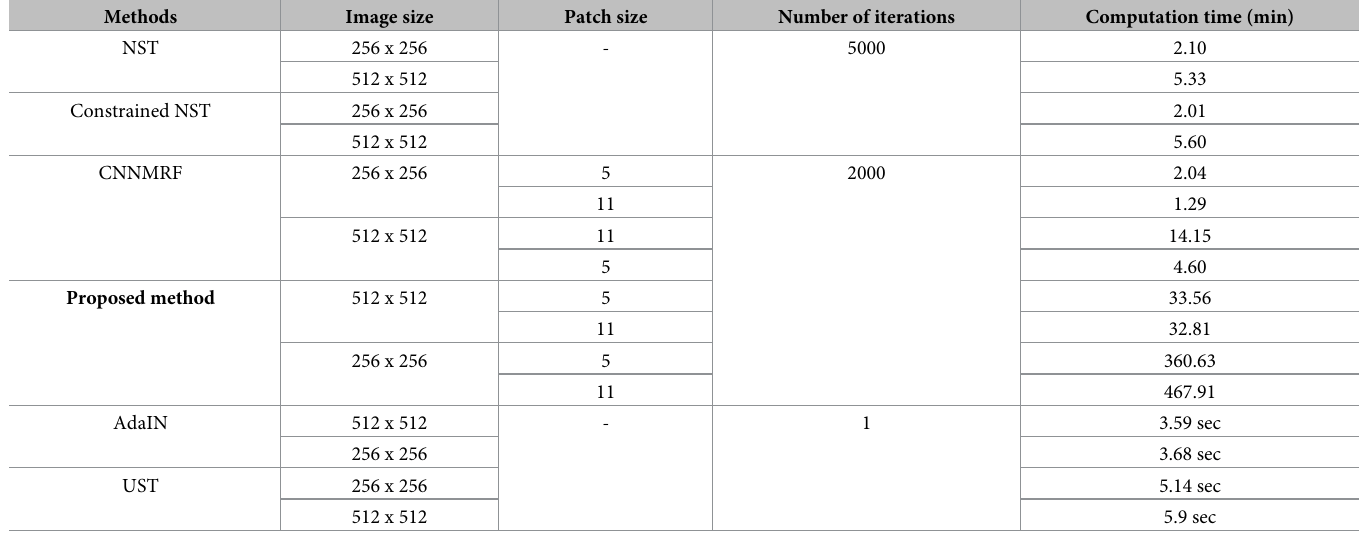
Table 2. Computation time of various